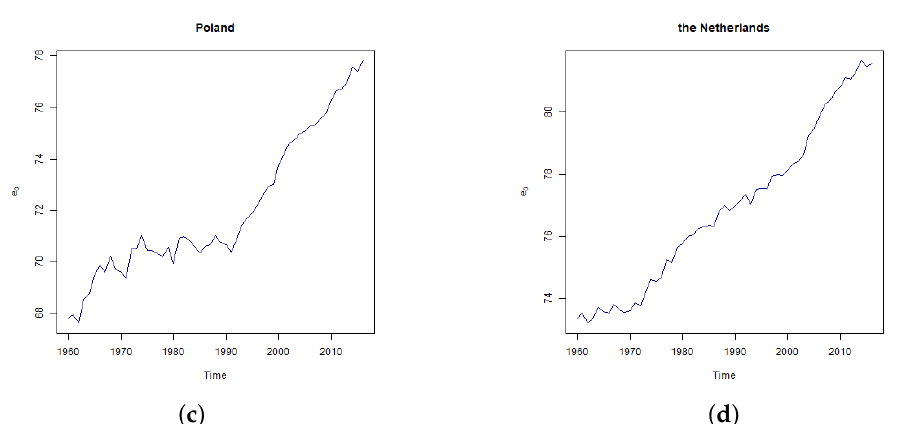
Figure 5. Development of periodic life expectancy at birth in Lithuania ( a ), Sweden ( b ), Poland ( c ) and the Netherlands ( d ) according to data from Human Mortality Database (2018).